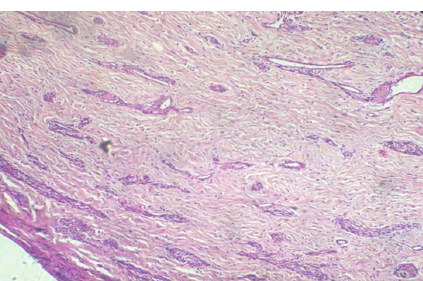
Figure 5: Fibrocellular connective tissue shows proliferating fibrob- last and numerous blood vessels (hematoxylin and eosin stain 10x).